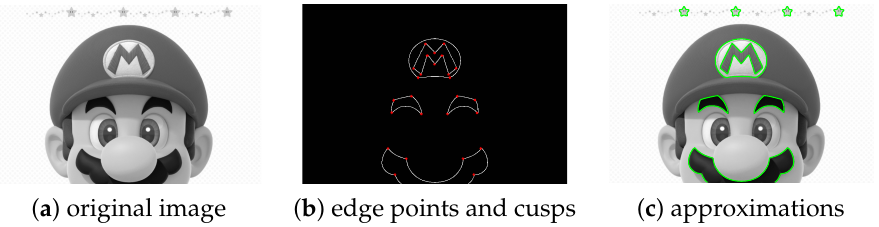
Figure 8. Recognition and approximation of different profiles in Super Mario. From the original image ( a ), we extract ( b ) and approximate the circle logo and the letter M therein, the eyebrows and the moustache ( c ).